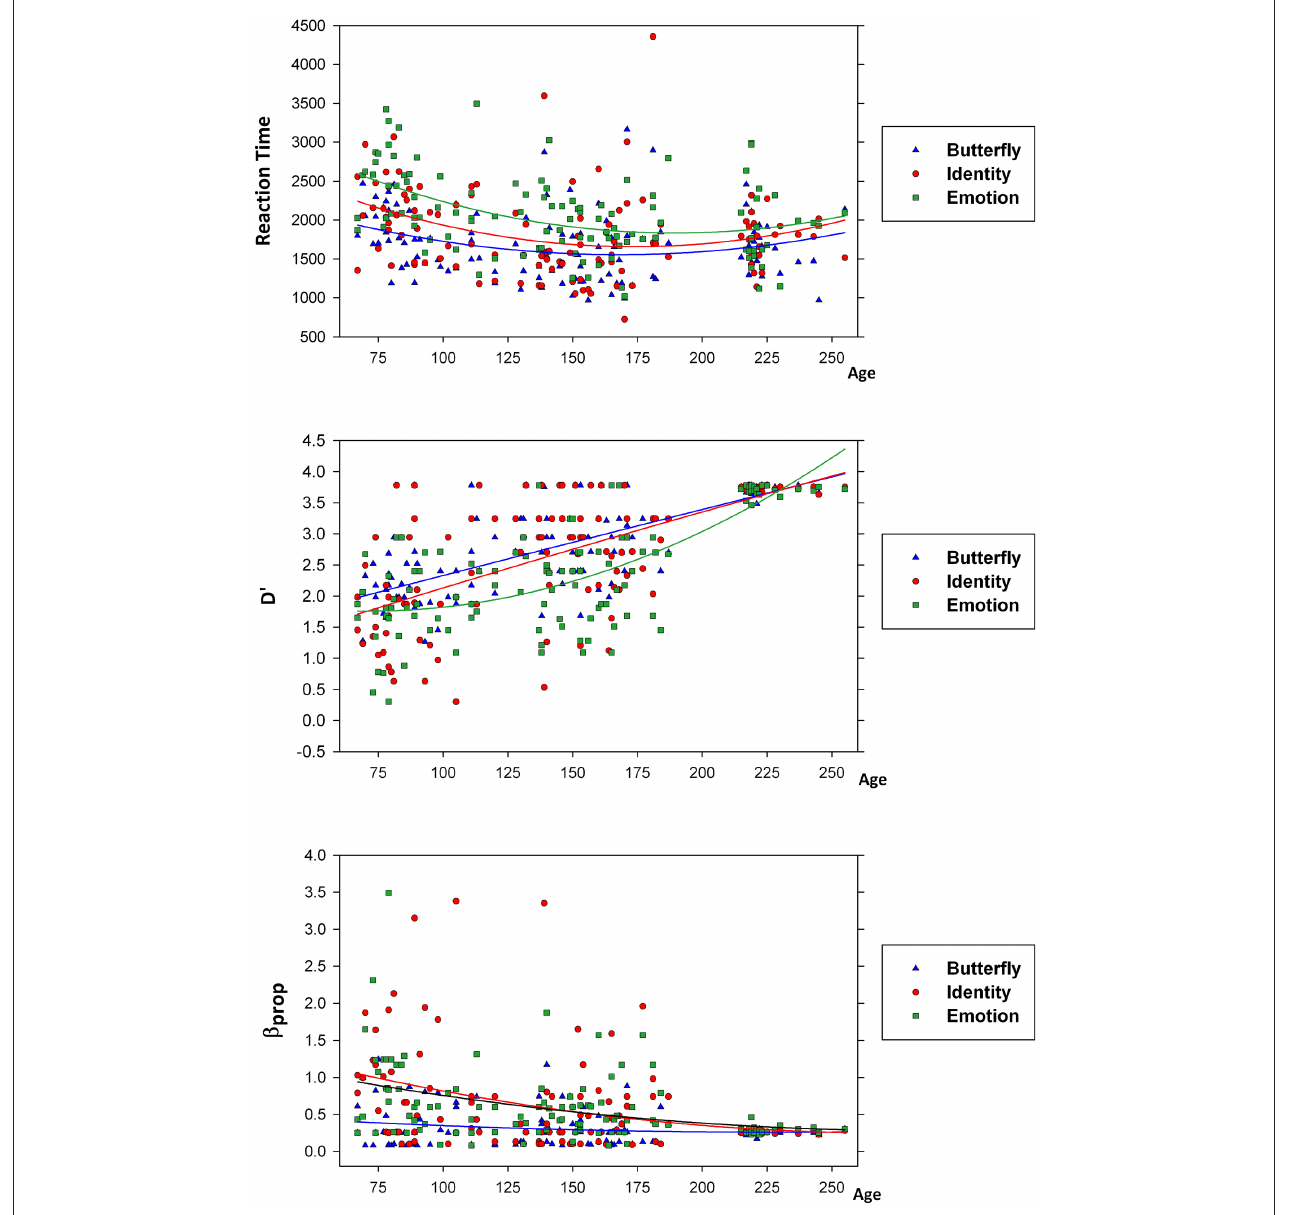
Figure 3 | Scatterplots of reaction time, d ′ and β